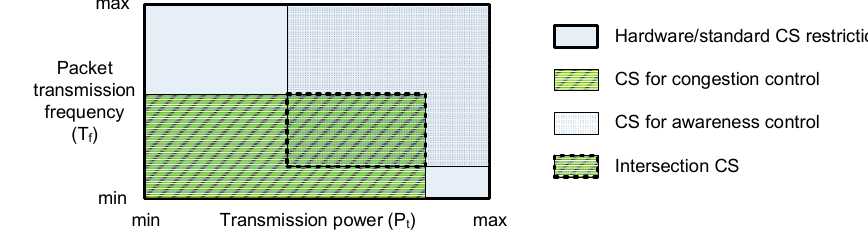
Figure 4. COMPASS configuration sets when coordinating congestion and awareness control protocols.